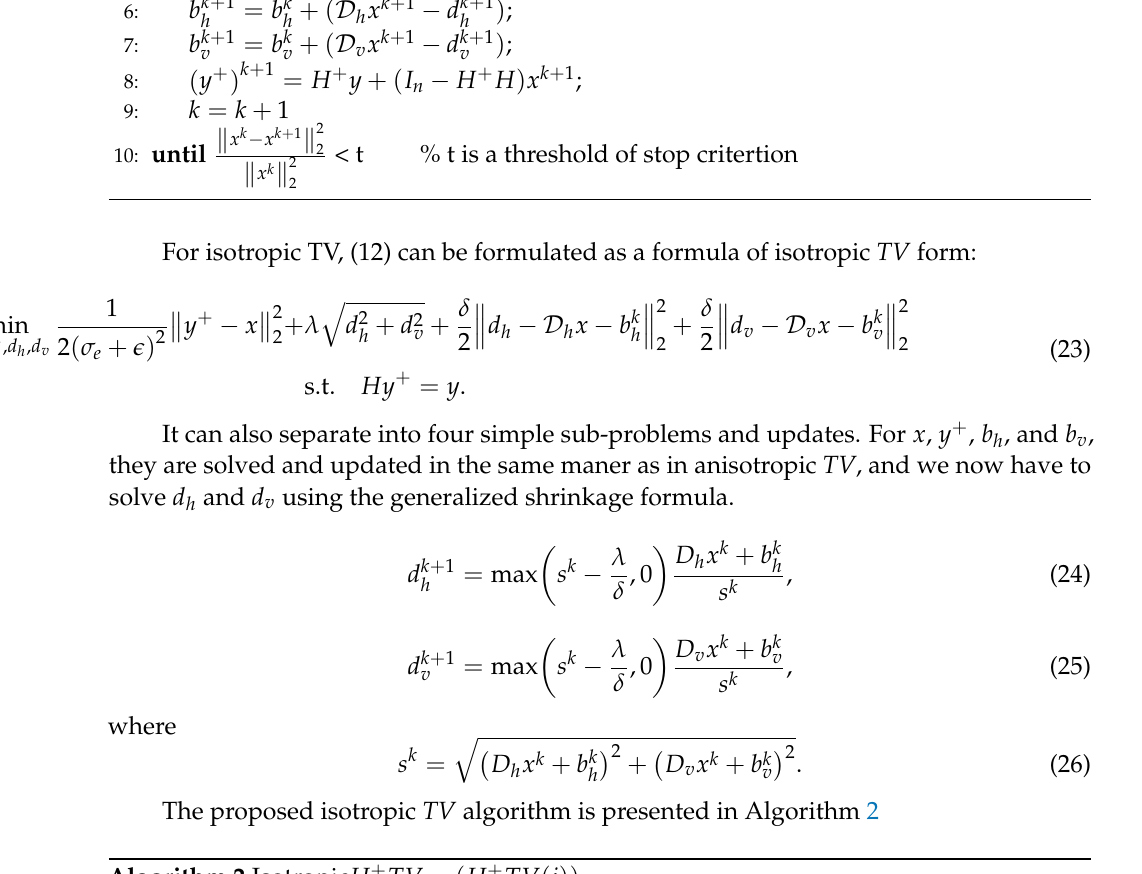
Algorithm 2 Isotropic H +